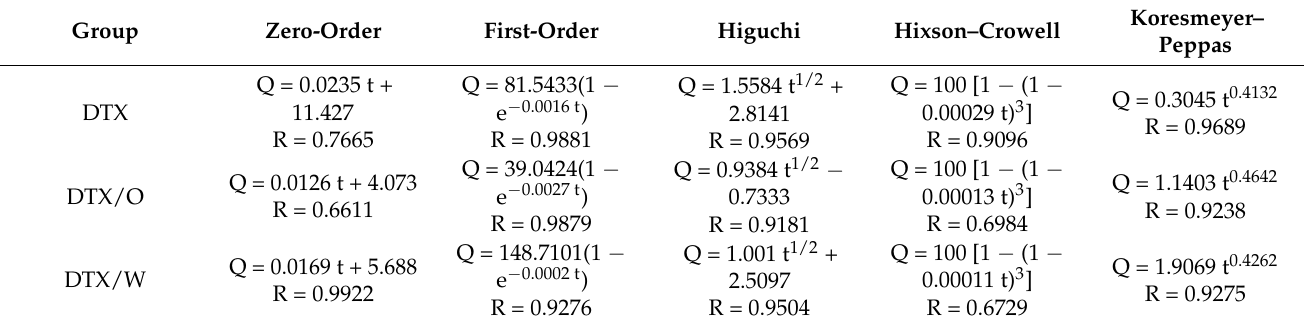
Table 4. Correlation coefficient values (R) for each mathematical model of DTX, DTX/O and